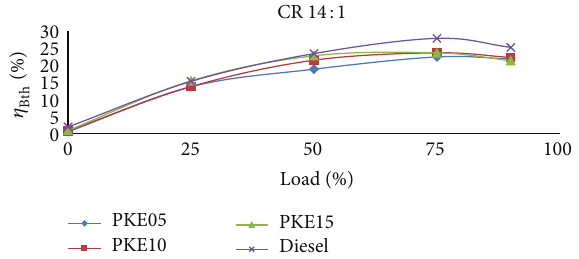
Figure 1: Load versus brake thermal efficiency at 14: 1 CR.